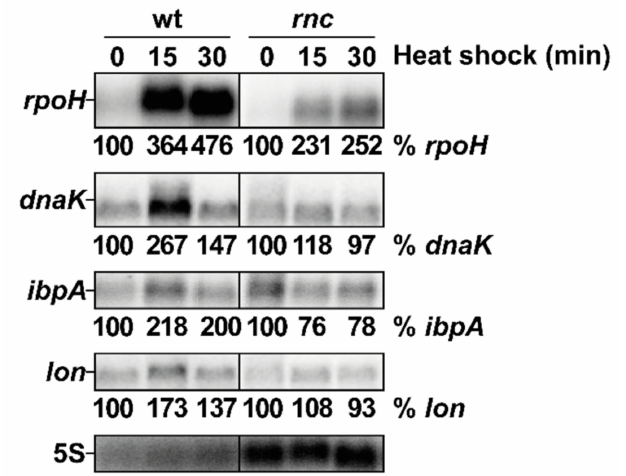
Figure 4. RNase III positively controls the induction of rpoH and of three targets of the RpoH regulon after heat shock. Strains wt and rnc were grown at 30 ◦ C and shifted to 45 ◦ C. Total RNA samples were taken before (time 0) or at the indicated time after the heat shock and analyzed by northern blot. The membrane was probed successively (after removal of previous signals) for rpoH , dnaK , ibpA , lon and 5S. Quantification of the different transcripts is given as % of the indicated mRNA in the wt at 30 ◦ C normalized to the 5S rRNA charge